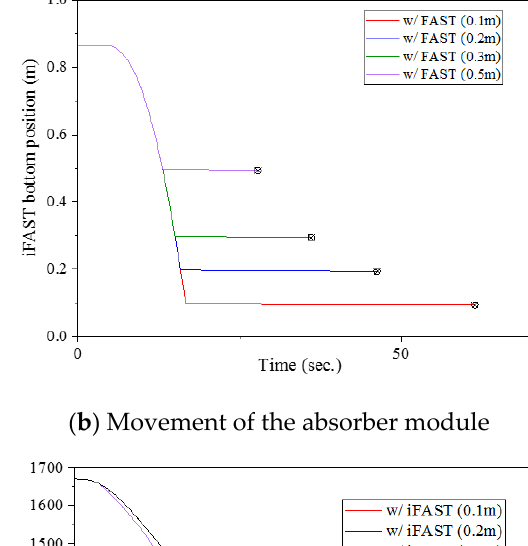
Figure 12. Unprotected loss of heat sink in ABR reactor and 1.8$ maximum iFAST worth